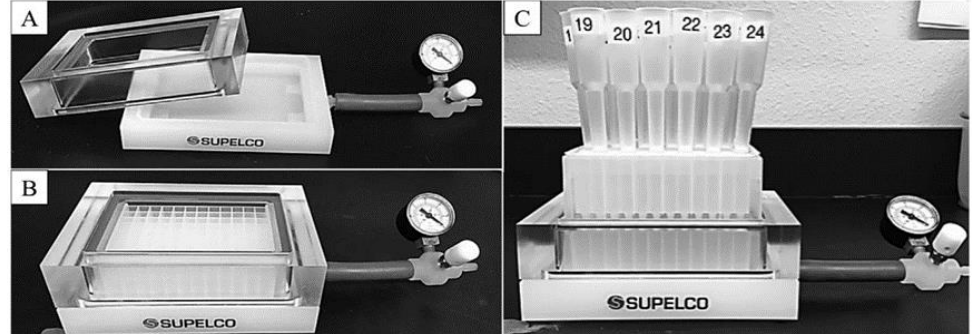
Figure 4. The multi column plate adapter (MCPA) with columns. ( A ) Front view of. MCPA (long drip filter plate with sealing mat) with 24 columns attached. The MCPA guides samples from each column into a 96, 48 well or open collection plate. ( B , C ) Top and bottom view of sealing mat respectively. 6 evenly spaced holes are made per row over alternating lines [9].